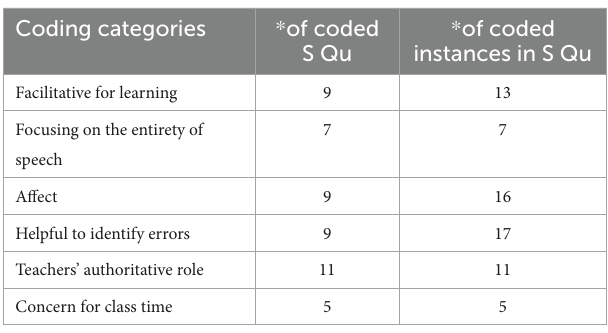
TABLE 7 Reasons for the students’ CF